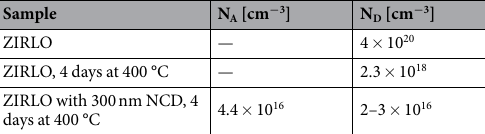
Table 2. Acceptor and donor densities obtained from the Mott-Schottky plots for uncoated ZIRLO before and after hot steam exposure and for NCD-coated ZIRLO samples after hot steam exposure. The uncoated ZIRLO exhibited n-type semiconductive behavior, whereas the NCD-protected ZIRLO after hot steam exposure exhibited mixed p- and n-type semiconductive